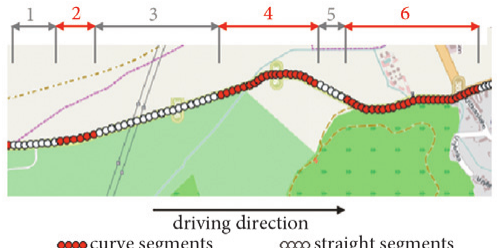
Fig. 7. Result of segmentation into curves and straight segments